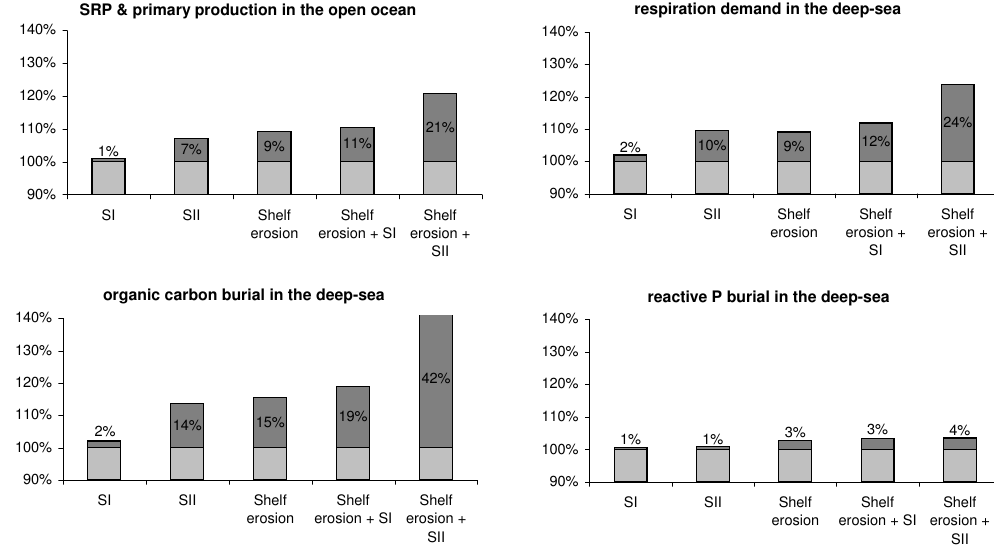
Fig. 4. Effect of shelf erosion and rerouting of particulate material during glaciations on the biogeochemical cycling of the open ocean at the last glacial maximum (LGM). Light gray bars represent the values of biogeochemical variables (dissolved P reservoir (SRP), primary production, respiration demand, organic C and reactive P burial) at the LGM for the standard glacial-interglacial scenario used in Tsandev et al. (2008). Dark gray bars illustrate the change of value in these variables under different scenarios implemented in this paper. The 5 scenarios include the standard glacial scenario of Tsandev et al. (2008) plus formation of submarine canyons according to scenario SI and formation of submarine canyons according to SII, the erosion of 6.3TmolC/yr over 50kyr (shelf erosion), and a combination of the above. In all cases, moderate redox dependent burial of organic and authigenic P is assumed as per Slomp and Van Cappellen